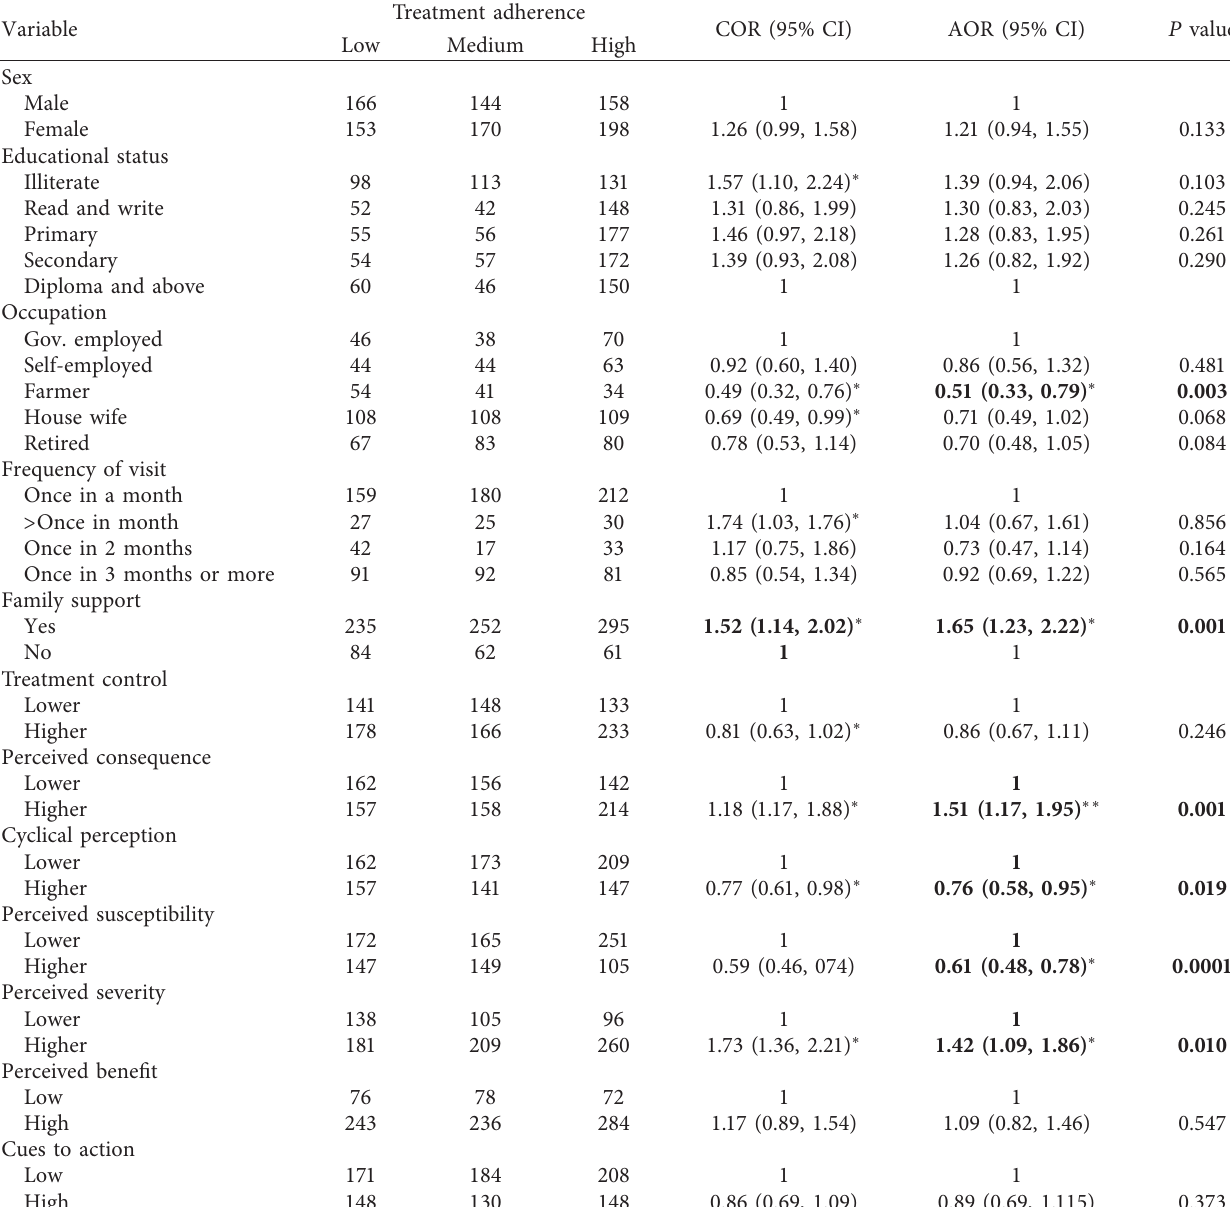
Table 7: Effect of selected variable and other characteristics on adherence to antihypertensive treatment in Central Ethiopia, 2017.